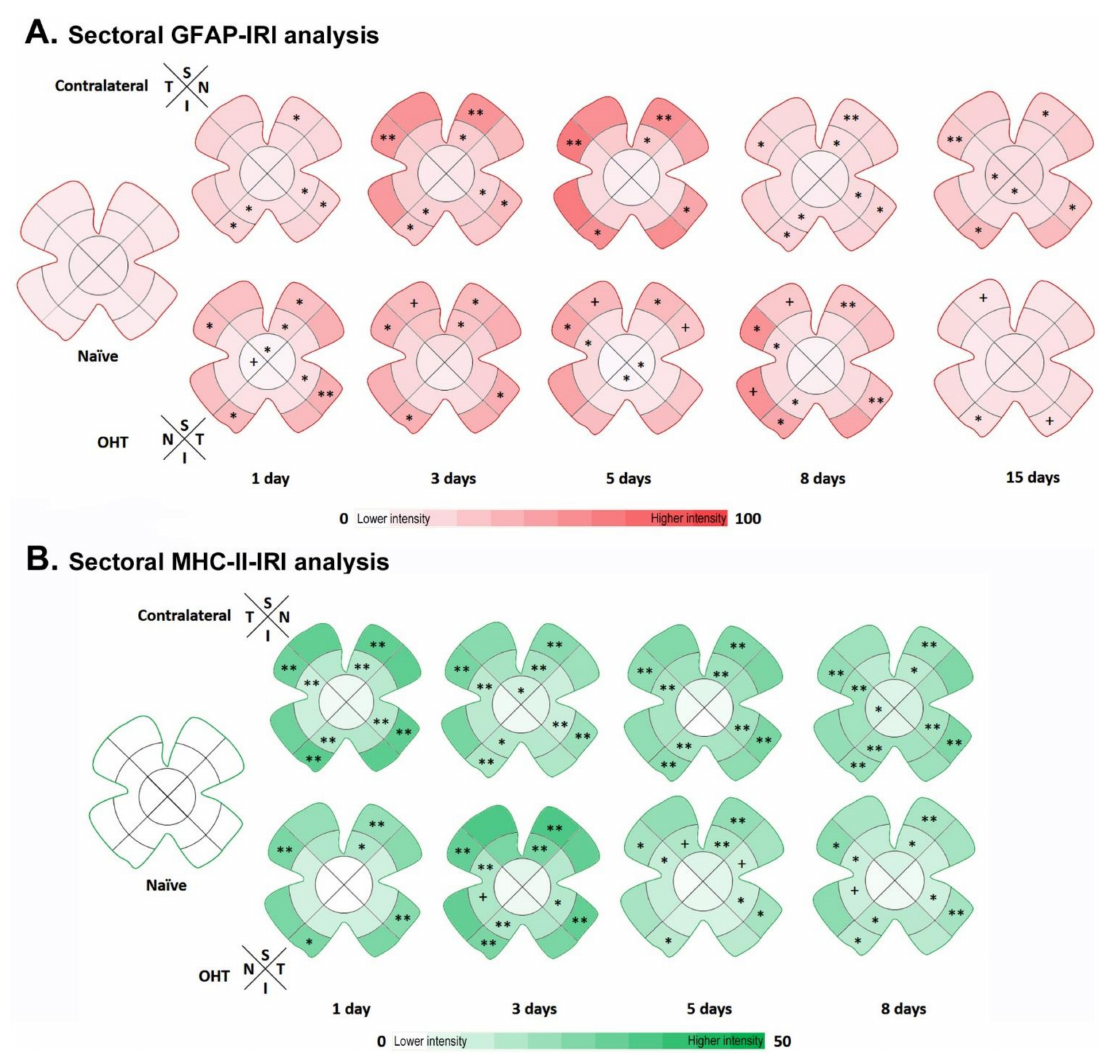
Figure 10. GFAP-IRI and MHC-II-IRI values at different time points after unilateral OHT laser- induction. ( A ): Colorimetric differences in the GFAP-IRI by retinal sectors in naïve eyes and at different time points after laser treatment (1, 3, 5, 8 and 15 days) in contralateral and OHT